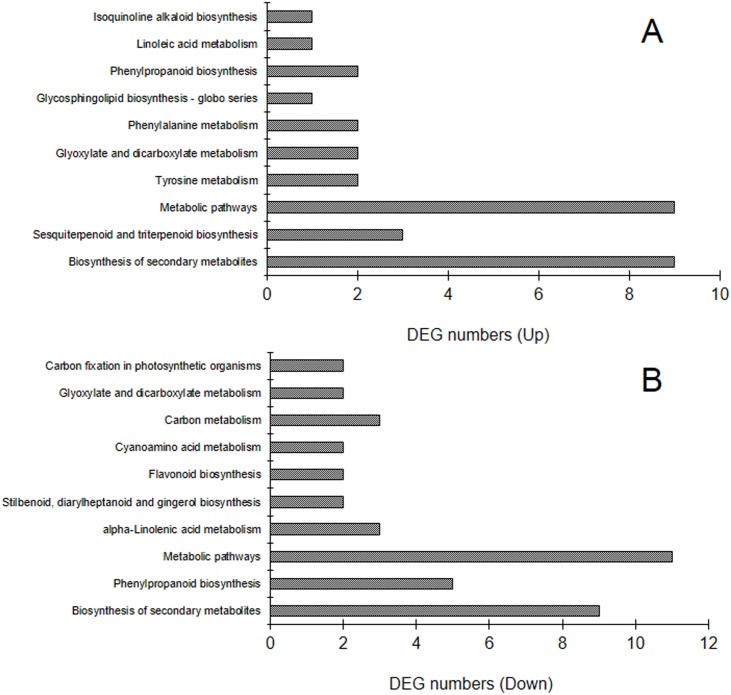
Statistics of KEGG enrichment of the up-regulated (A) and down-regulated (B) common DEGs.Histograms indicate 10 most abundant KEGG pathways.